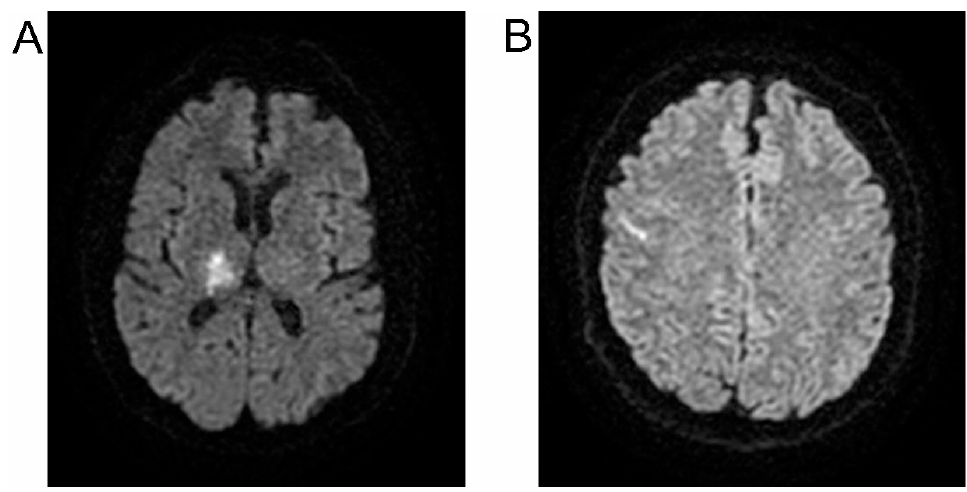
Figure 2. Examples of MRI pictures in DWI sequences presenting acute ischemic areas in patients from the NMFES+K group ( A ) and the K group ( B ).